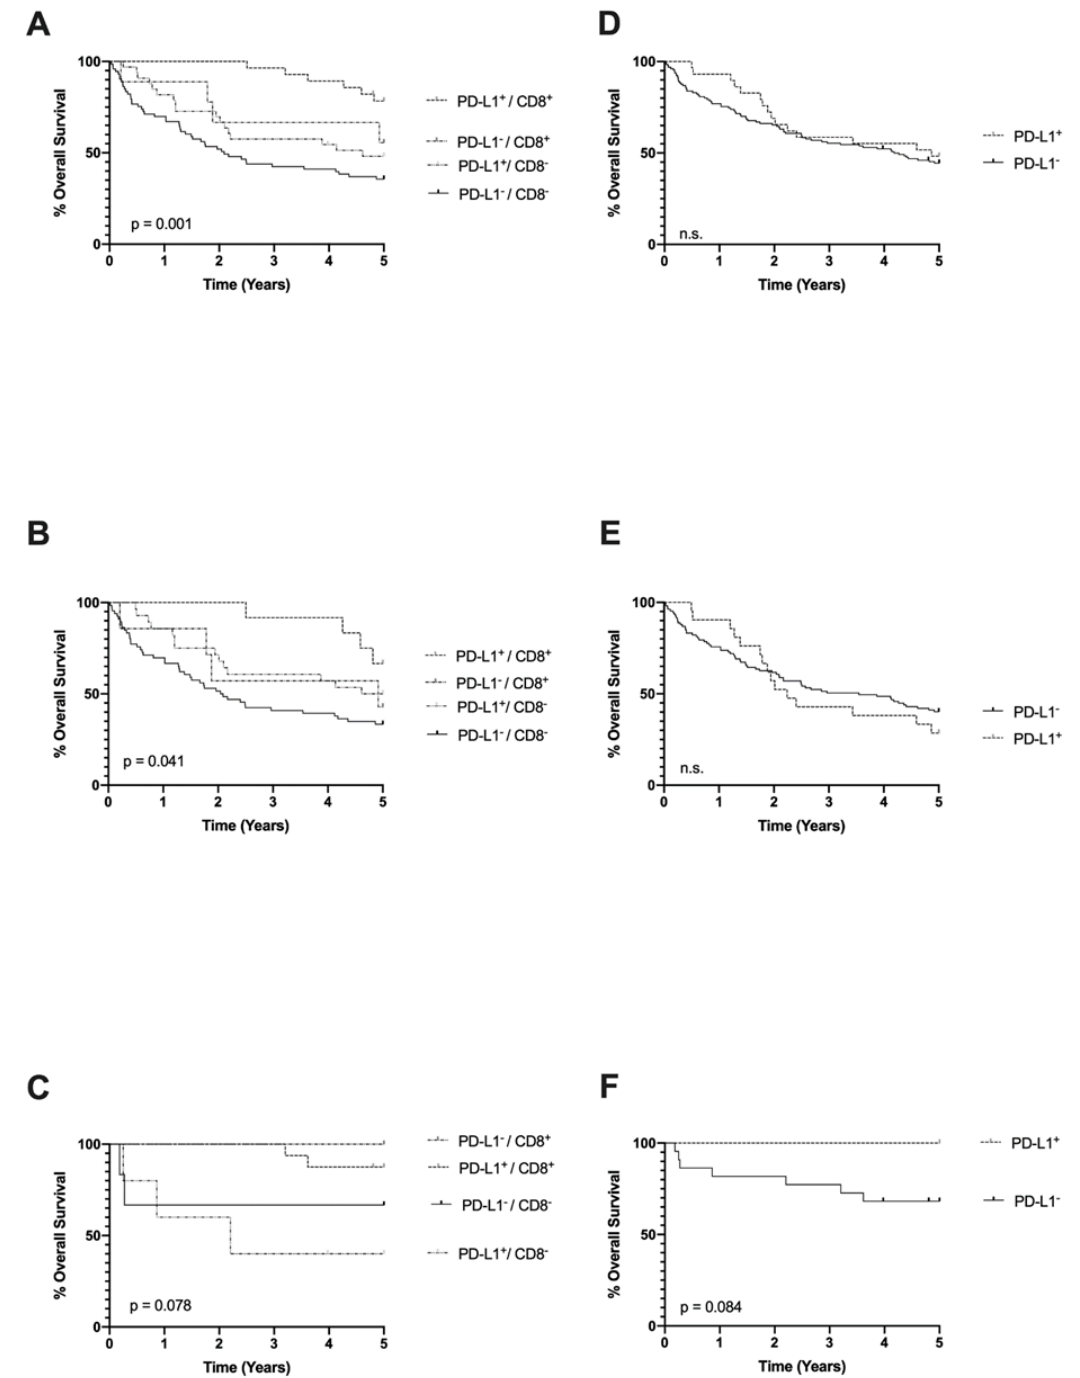
Figure 2. Overall survival according to PD-L1 expression on TC and CD8 + infiltrating lymphocytes in OPSCC in the whole cohort ( A ) in human papillomavirus (HPV)-negative OPSCC ( B ) and in HPV-related OPSCC ( C ). Survival according to PD-L1 expression on macrophages in the whole cohort ( D ), HPV-negative ( E ), and HPV-related ( F ) OPSCC (p-values calculated by log-rank test).